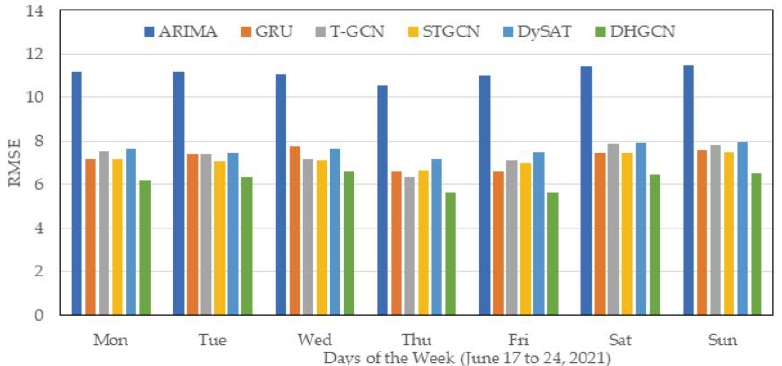
Figure 4. Modeling performance for days of the week (17 to 24 June 2021).